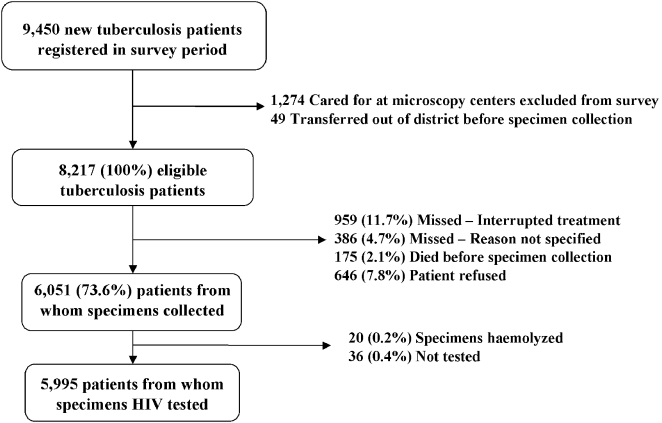
Survey enrollment and inclusion, with reasons for non-eligibility and non-enrollment into survey.